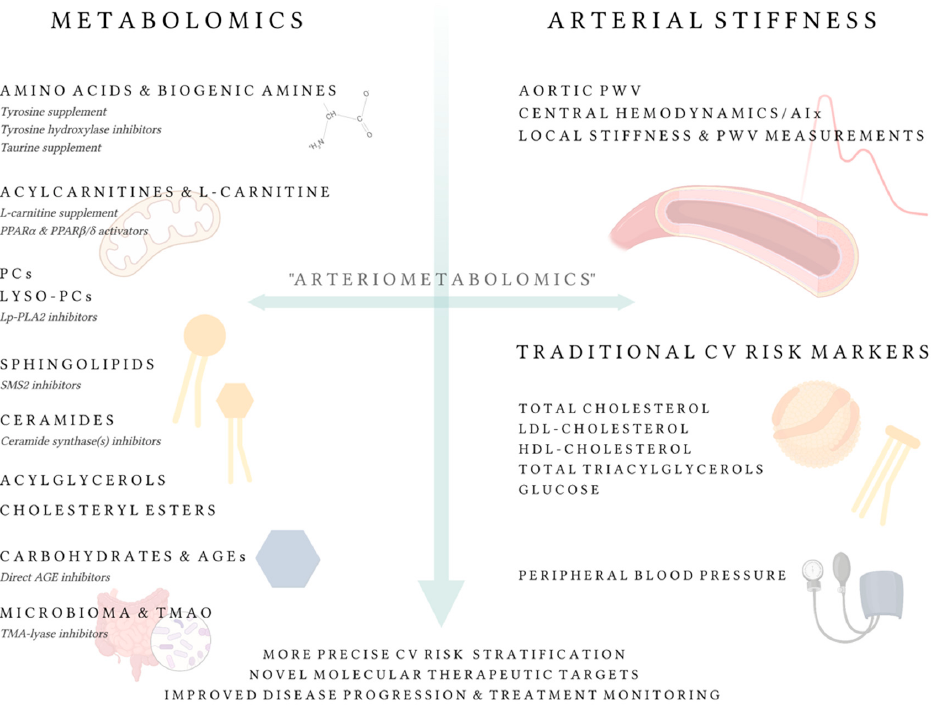
Figure 2. ‘Arteriometabolomics’—the crossroad of metabolomics and arterial stiffness research. Metabolites or groups of metabolites that have been associated with arterial stiffness are listed on the left. Metabolism-related compounds that deserve further preclinical/clinical study as potential therapeutics against vascular ageing are displayed in italics. Abbreviations: AGE, advanced glycation end-product; CV, cardiovascular; HDL, high-density lipoprotein; LDL, low-density lipoprotein; Lp-PLA2, lipoprotein-associated phospholipase A2; lyso-PC, lysophosphatidylcholine; PC, phosphatidylcholine; PPAR, peroxisome proliferator-activated receptor; PWV, pulse wave velocity; SMS2, sphingomyelin synthase 2; TMA, trimethylamine; TMAO, trimethylamine N-oxide.